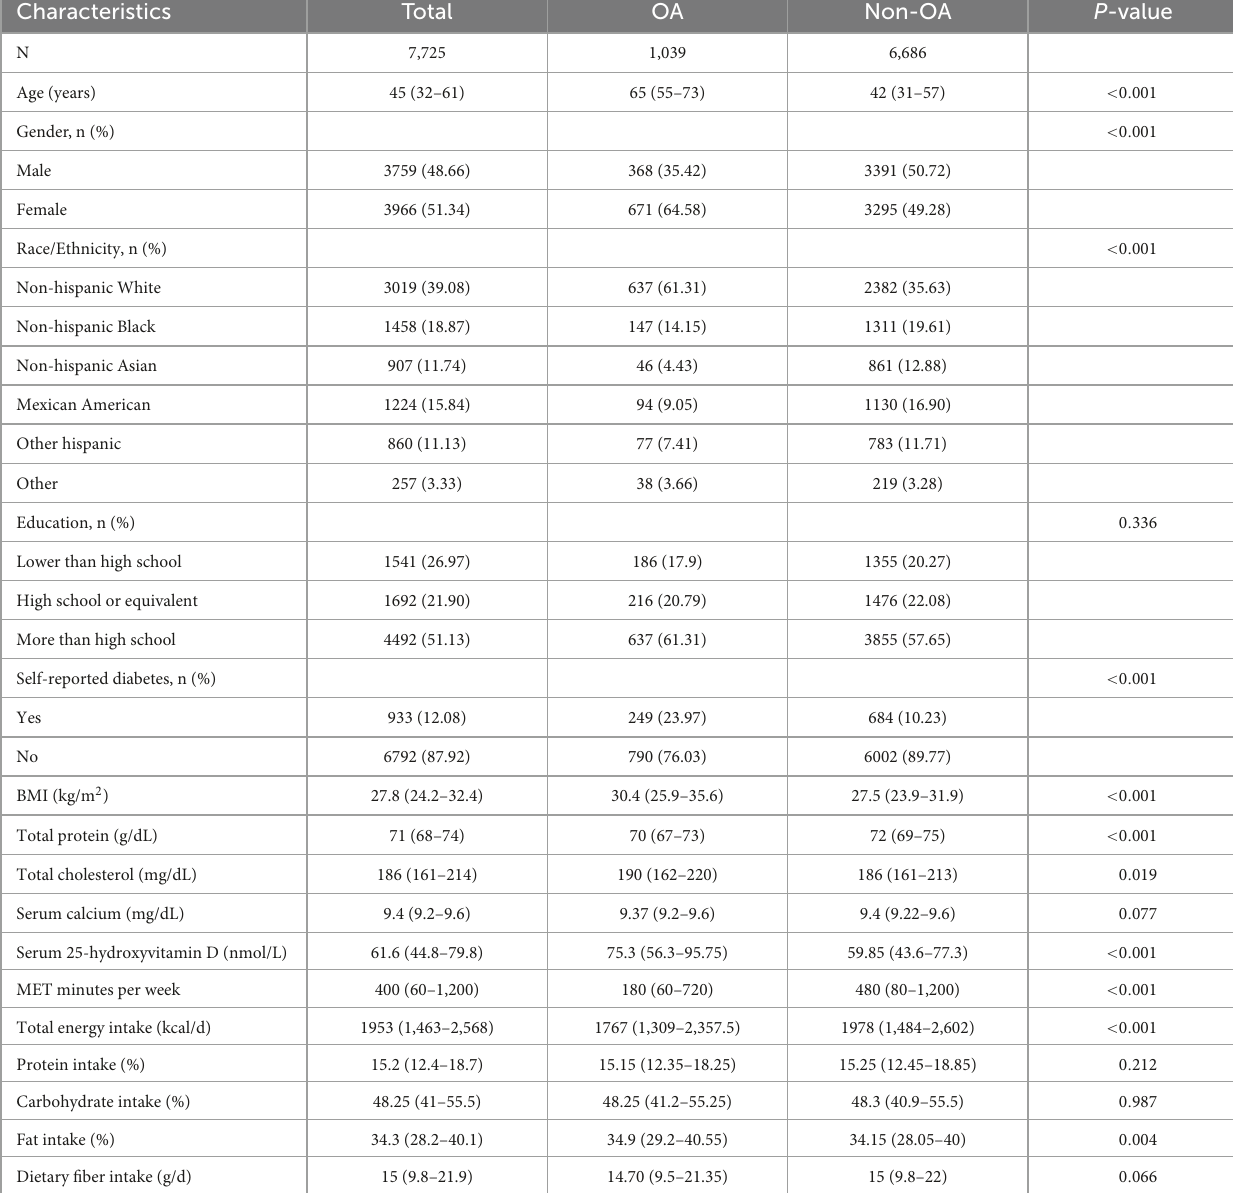
TABLE 1 Characteristics of participants stratified by self-reported osteoarthritis (OA) status ( N = 7,725). Characteristics